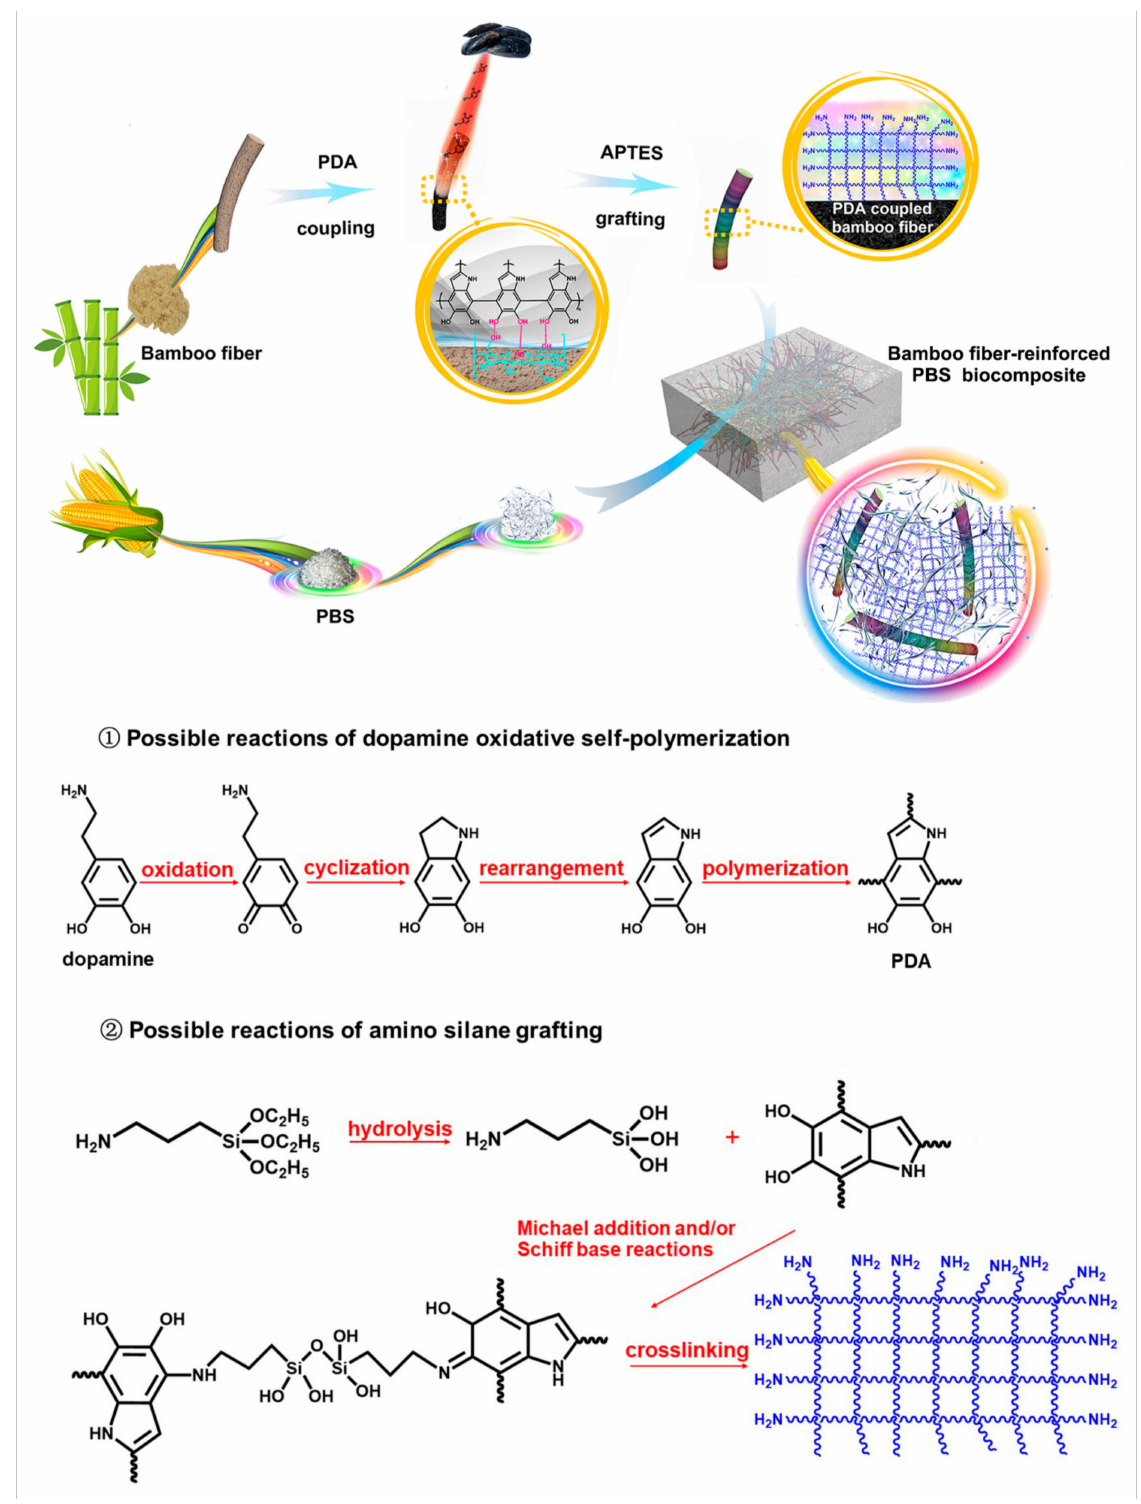
Figure 14. A scheme illustrating the modification of the fiber, a reactive mechanism between modifiers and the fabrication of the biocomposites. Reprinted with permission from Elsevier